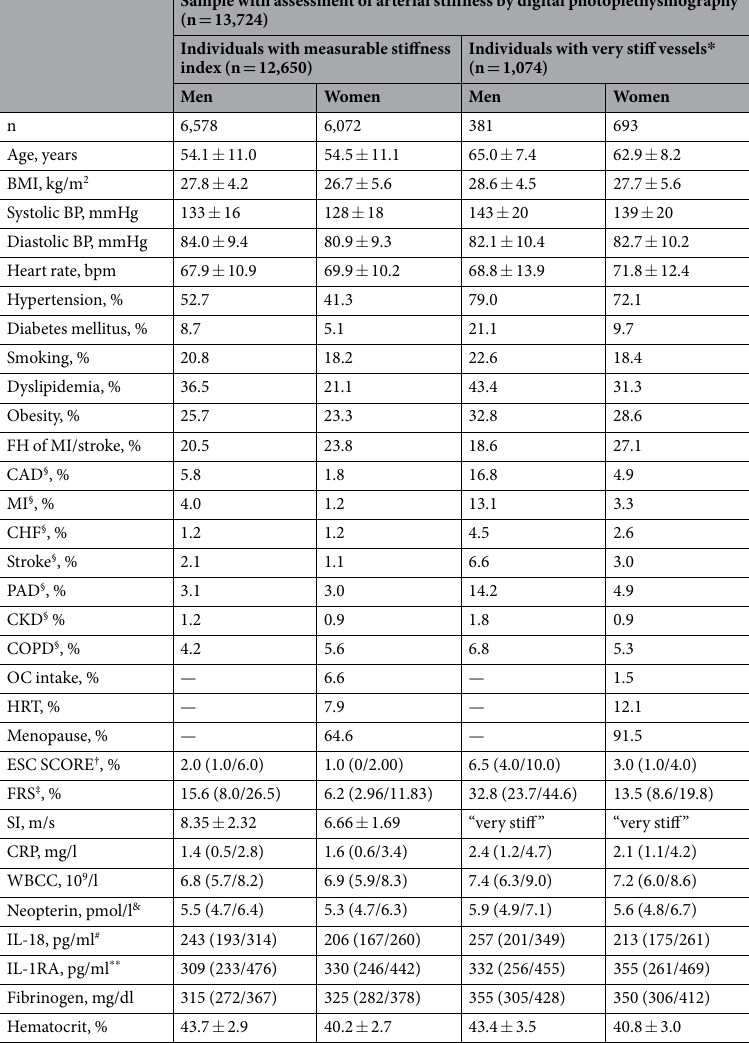
Table 1. Demographic, Clinical and Laboratory Characteristics of the Population-based Sample (n = 13,724). * No distinct notch in digital volume pulse waveform. § Information self-reported and medical records. † German version of the ESC SCORE. ‡ Framingham general CVD Risk Score. & n = 3,548 (1,886 men/1,662 women); # n = 4,078 (2,245 men/1,833 women); ** n = 4,442 (2,337 men/2,105 women). Data are expressed as mean with standard deviation or medians with 1 st /3 rd quartile. BMI stands for body mass index, BP for blood pressure, bpm for beats per minute, FH for family history, CAD for coronary artery disease, MI for myocardial infarction, CHF for congestive heart failure, PAD for peripheral artery disease, CKD for chronic kidney disease, COPD for chronic obstructive pulmonary disease, OC for oral contraceptives, HRT for hormone replacement therapy, FRS for Framingham risk score, SI for stiffness index, CRP for C-reactive protein, WBCC for white blood cells count, IL-18 for interleukin-18, IL-1RA for interleukin-1 receptor